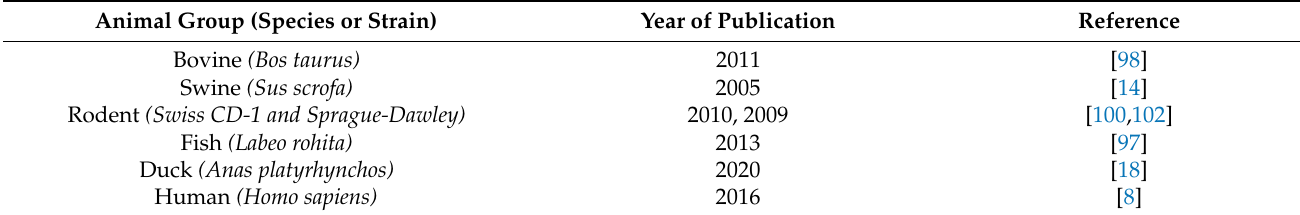
Table 1. Functional sperm TRPV1 channels described in different